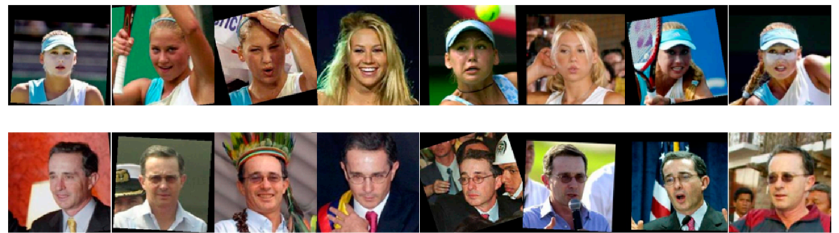
Figure 7. Examples of two different subjects from the Labeled Faces in the Wild (LFW)-a database.